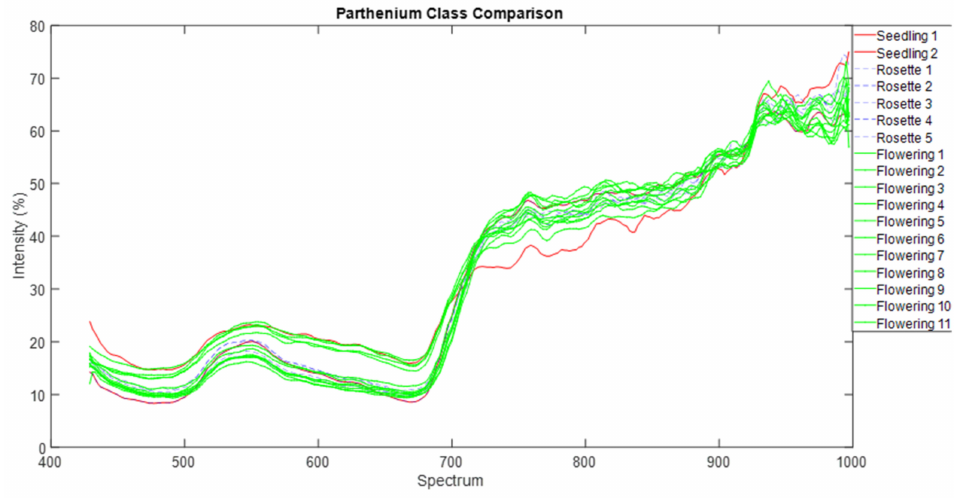
Figure 13. Spectral signature of all parthenium weed plants used in this investigation grouped in their respective growth stages.